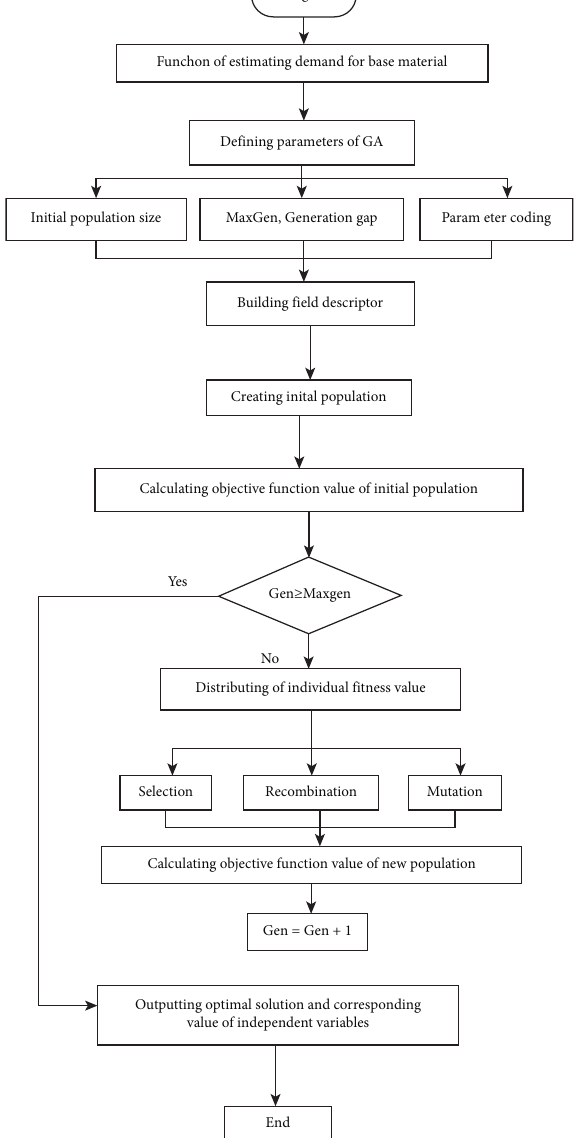
Figure 2: Multimedia resource topic search algorithm